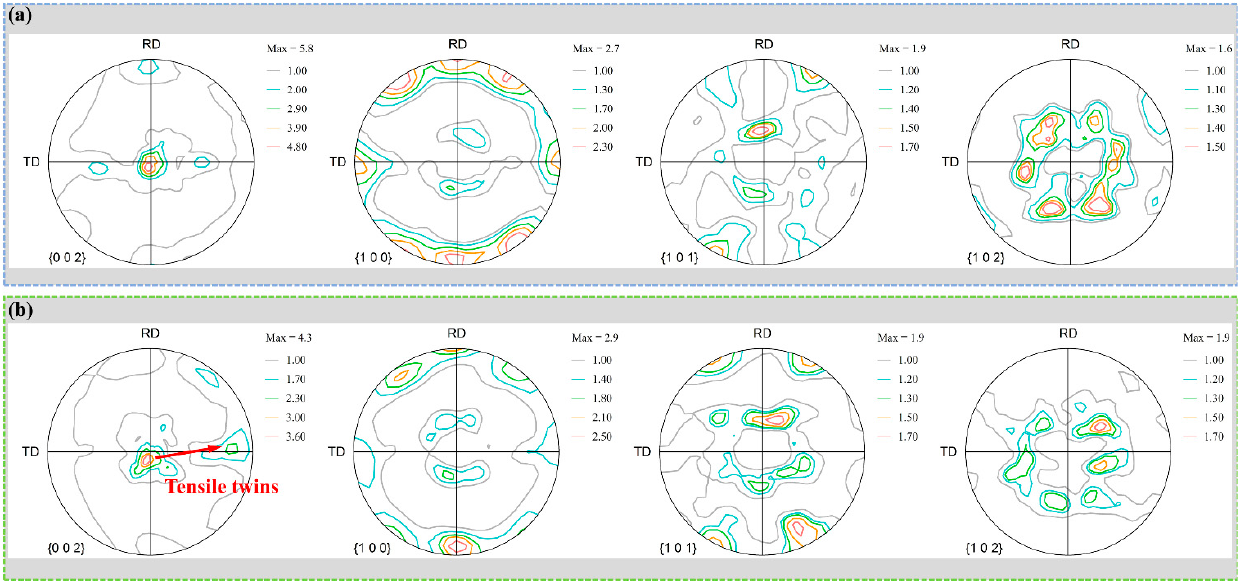
Figure 8. The macrotexture of ( a ) CR30% and ( b ) RR30%. At the same time, the Schmidt factor distribution chart of CR30%, CR50%, RR30%, and RR50% shown in Figure 9 also shows that the microstructure after conventional rolling is in ‘hard orientation’, which is not conducive to coordinated deformation. Since the cracking is a tensile force in the RD, the loading direction is set to RD.